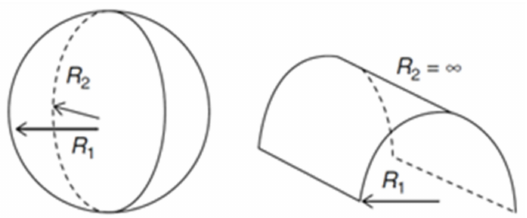
Figure 4. Self-assembled structures radii. Left: sphere with both radii positive; Right: cylinder with a positive finite radius and an infinite radius. Adapted from Marques and Silva, 2013